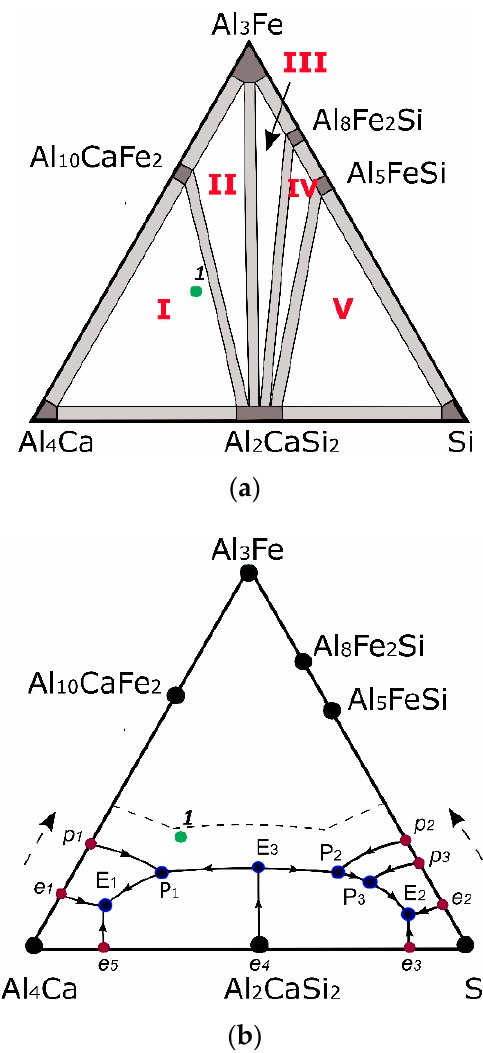
Figure 7. Phase diagram of Al–Ca–Fe–Si system in aluminum corner: ( a ) distribution of phases in the solid state and ( b ) polythermal projection. Point 1 corresponds to the chemical composition of the ACZ alloy.